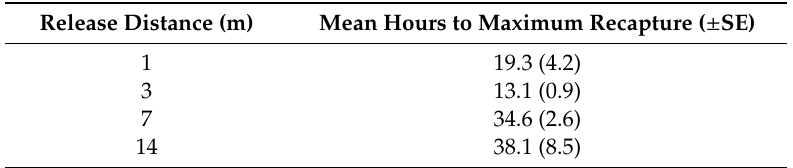
Table 3. Mean time (hours ± SE) to maximum recaptures for Agriotes obscurus beetles released at di ff erent distances away from a pheromone granule band (N =